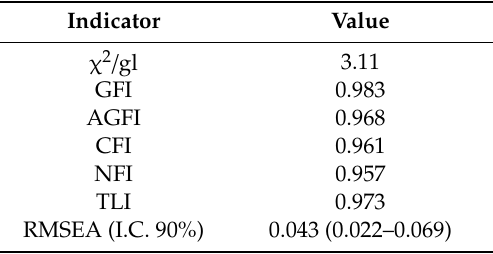
Table 4. Goodness of fit indexes (estimated final model).